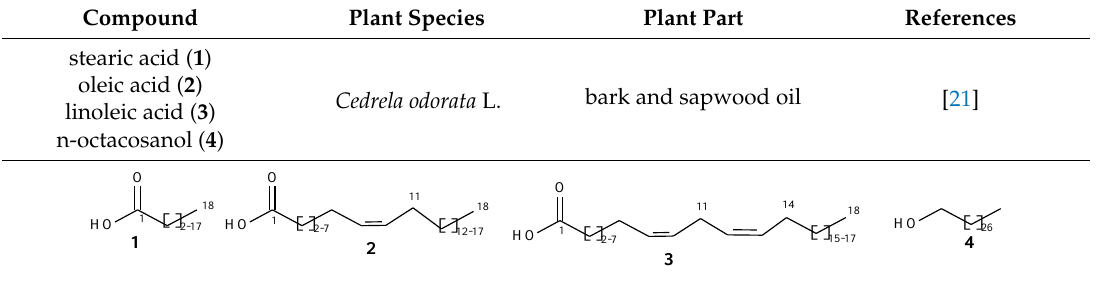
Table 1. Aliphatic acids and alcohol isolated from the genus Cedrela (1960–2020).